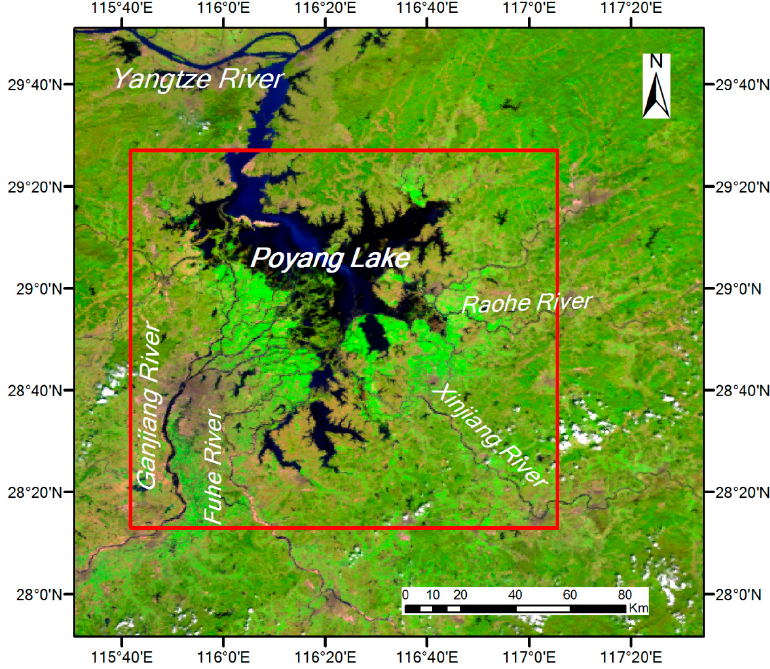
Figure 1. Study area displayed as NPP-VIIRS Imagery bands (R3G2B1).